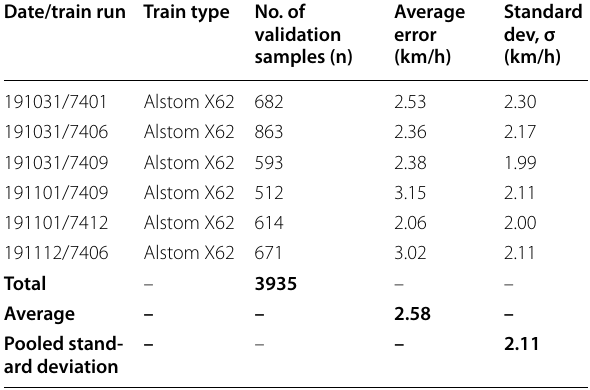
Table 3 Alternative 1: speed validation based on speed samples,